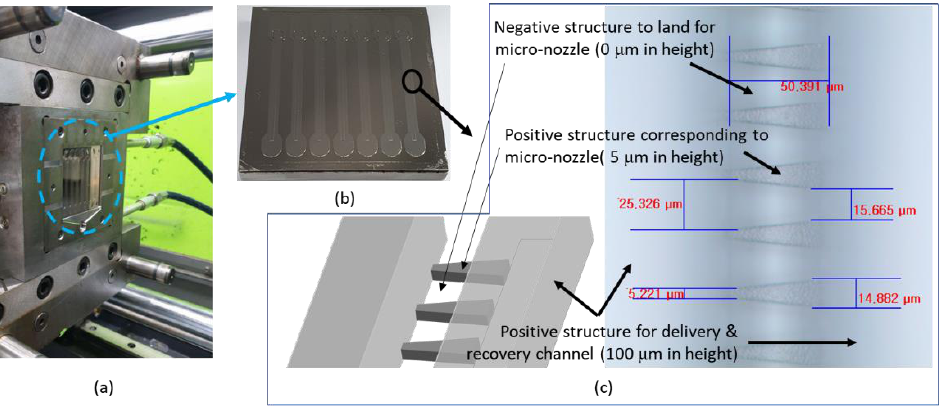
Figure 7. Images for ( a ) half of mold with an insert for injection molding, ( b ) micro-channel stamper insert, and ( c ) micro-channels and micro-nozzles on the stamper.